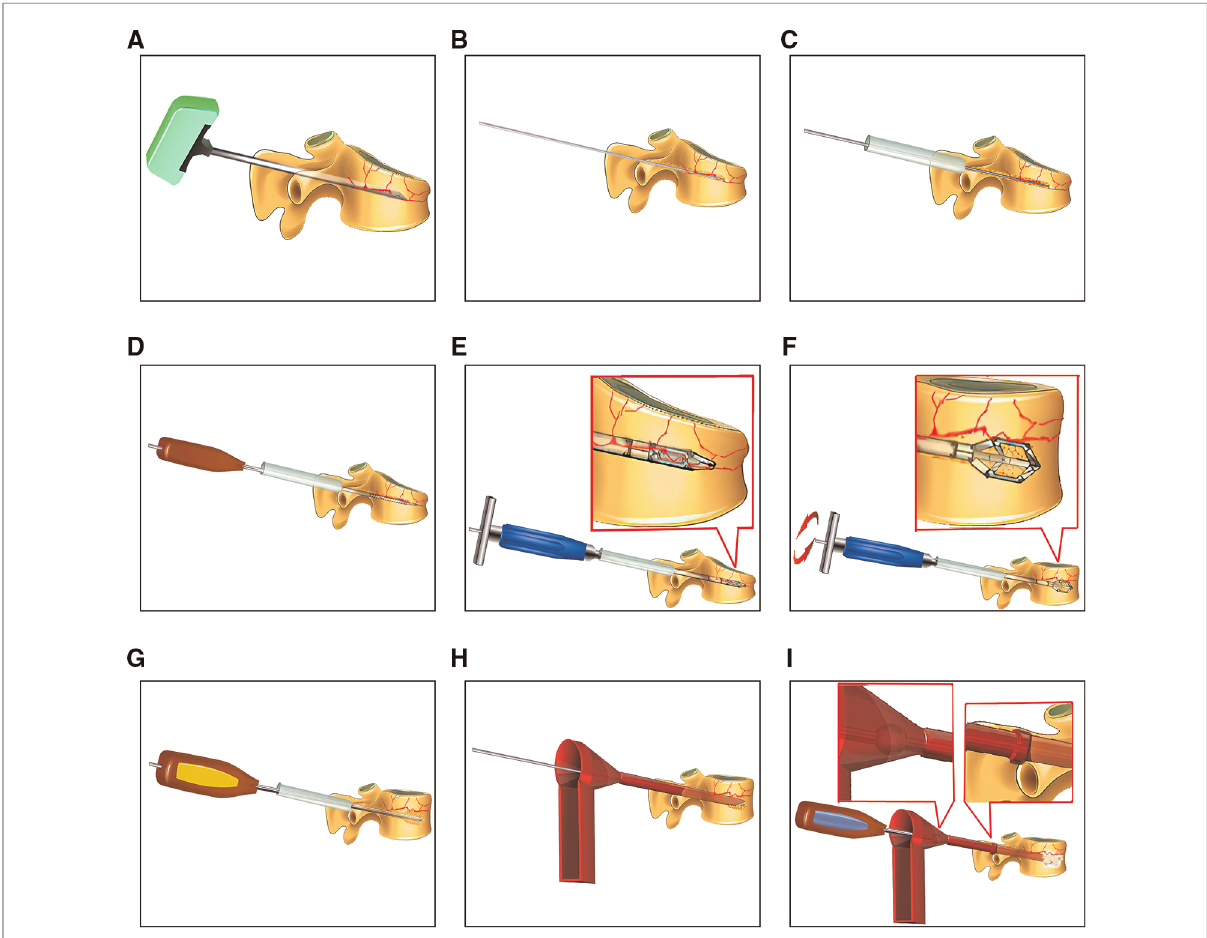
FIGURE 1 Illustration of PPSR procedures. ( A ) A puncture needle inserted into the appropriate depth of the fractured vertebra as examined by fl uoroscopy. ( B ) A guide needle inserted into the vertebral body. ( C ) A hollow sleeve created to protect the surrounding soft tissues and guide the devices. ( D ) A rotary chisel applied to establish a channel for the percutaneous distractor. ( E,F ) The percutaneous vertebral distractor inserted into the fractured vertebra; the vertebral distraction was achieved by turning the percutaneous vertebral distractor. ( G ) A channel dilator was used to enlarge the channel for bone grafting. ( H ) Bone grafting through a funnel. ( I ) A bone grafting rod was used to push the bone graft materials into the injured vertebra. An accessory ball was applied to limit the depth range of the bone grafting rod. Range of the bone grafting